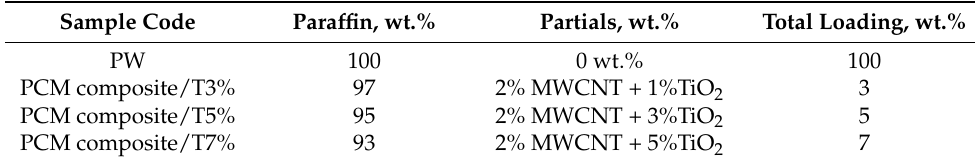
Table 3. Mass of nanoparticles in paraffin used in this study.